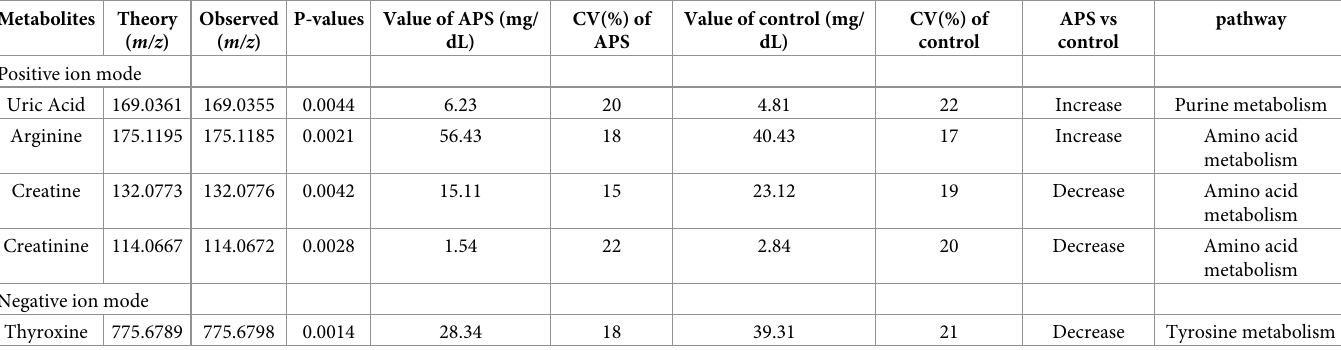
Table 2. Identification results and the change trends of the biomarkers. Metabolites Theory ( m/z